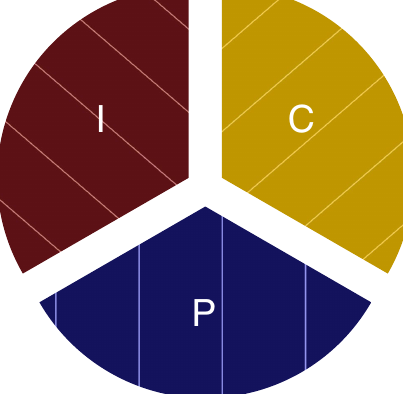
FIG. 2. A depiction of the three pedagogical modes articulated by Hinko in Ref. [12]. Each mode, defined categorically by its CHAT elements, is separate from each other mode.